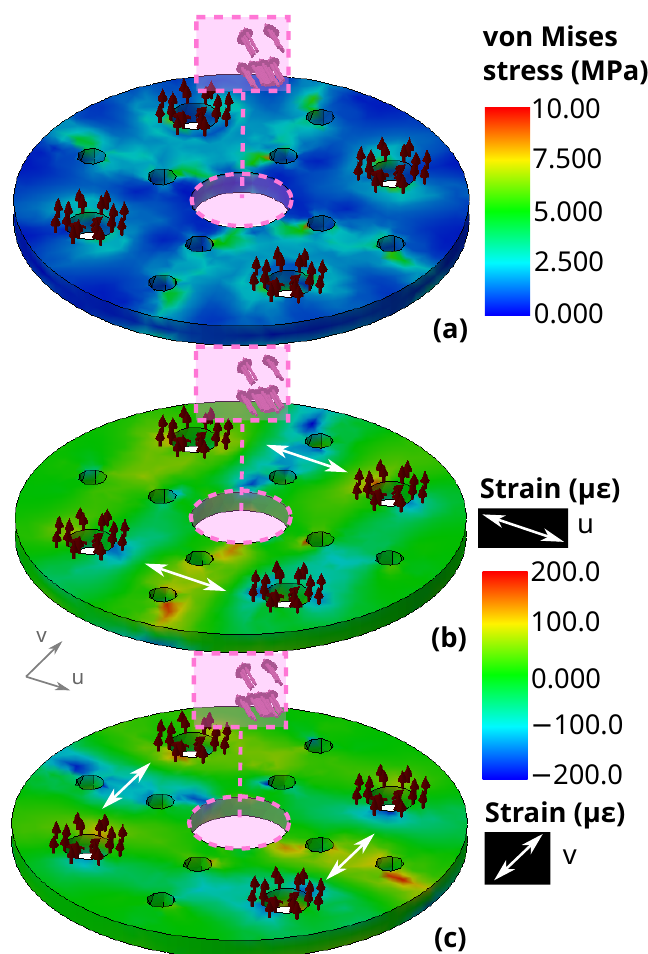
Figure A1. FEA simulation of a 10.0 N force in the X-direction applied 15.5 mm from the center of the 3-DOF sensor. Applied forces are represented by pink arrows with the moment arm in dashed pink lines, while support fixtures are represented by brown arrows. Surface coordinates u and vs. are represented by a grey frame. All results are viewed from top surface. Results include ( a ) von Mises stress field, ( b ) u-direction strain, and ( c ) v-direction strain fields. The axis being referenced for strain measurement is indicated by a white bidirectional arrow on the surface of the sensor at the gauge locations. The two strain axes are perpendicular, but are offset from established X-Y axes by 45